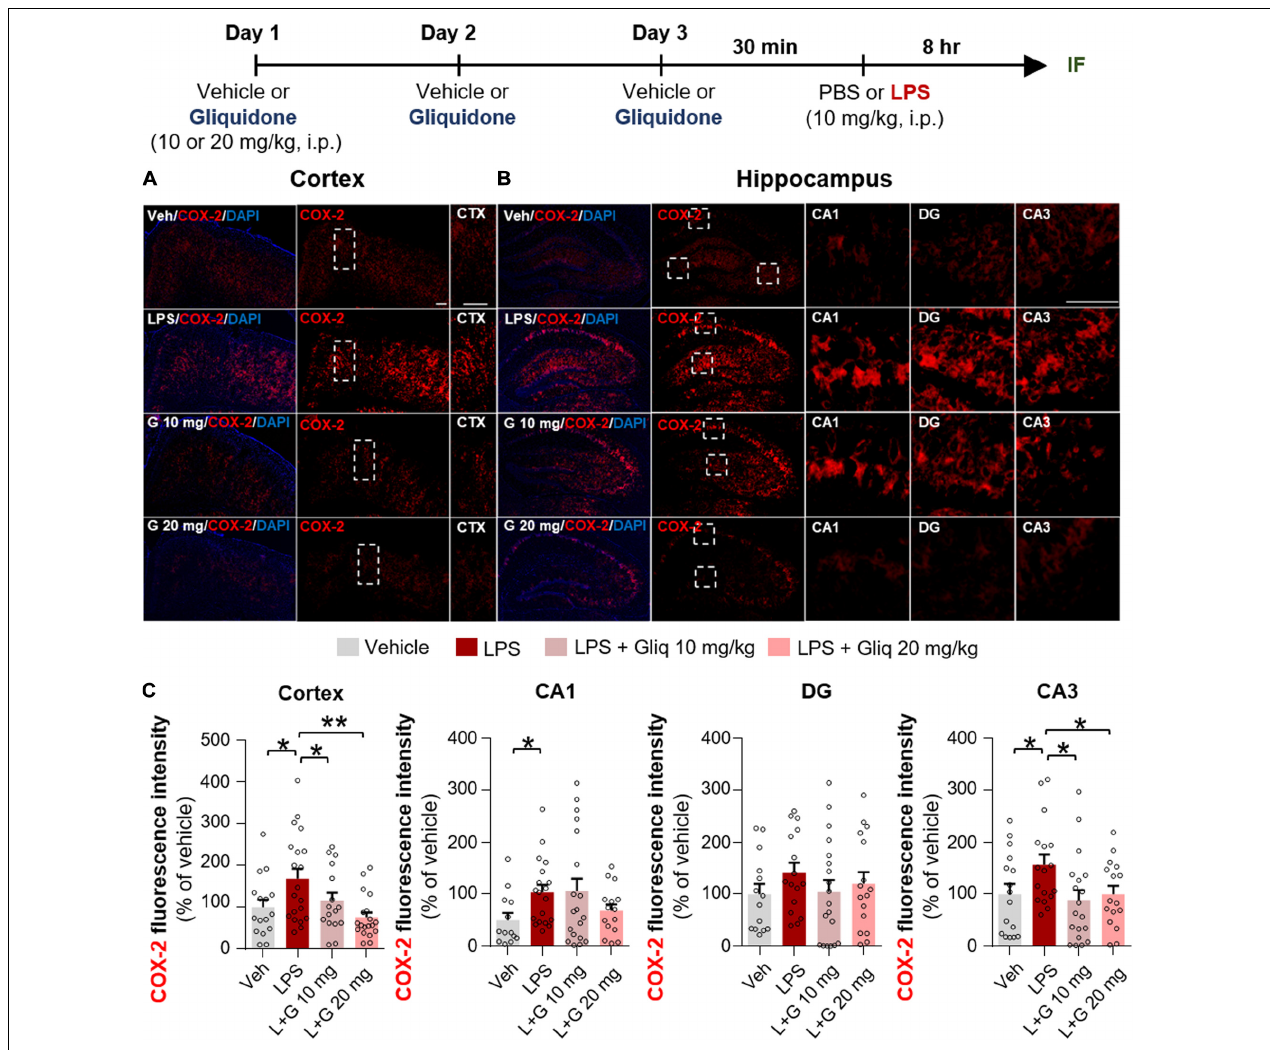
FIGURE 3 | Gliquidone diminishes the LPS-induced elevation of COX-2 levels in the brain in C57BL6/N mice. (A,B) Immunofluorescence staining of COX-2 expression in brain slices from mice treated as shown at the top of the figure. (C) Quantification of the results in (A,B) ( n = 11–18 brain slices from 4 mice/group). * p < 0.05, ** p < 0.01, Scale bar = 100 µ